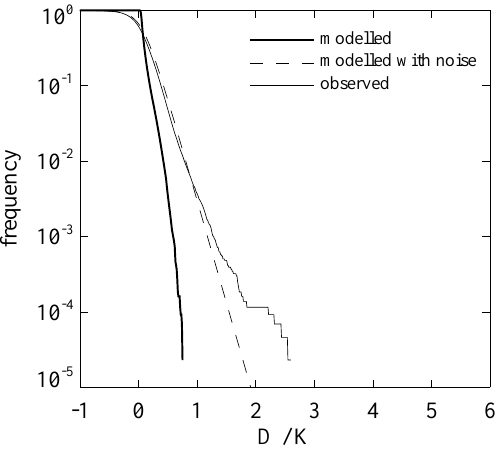
Fig. 5. Fit between the probability distributions of modelled warm- ing >D and observed warming >D at 18:00LT for large integrated heat flux (23MJm − 2 ) . The modelled warming ranges from zero to 4K. Adding background noise has little effect on the distribution since the distribution is already